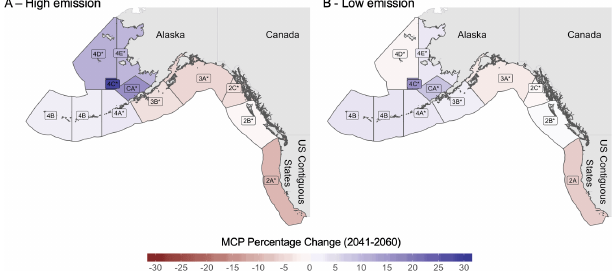
Fig. 2 . Percentage change of maximum catch potential (MCP) for species managed by the International Pacific Halibut Commission for mid-21st century (2041–2060) relative to the present 2005–2014 under a (A) high emission scenario and (B) low emission scenario. Labels marked with “*” represent regions where models do not agree in direction of change.